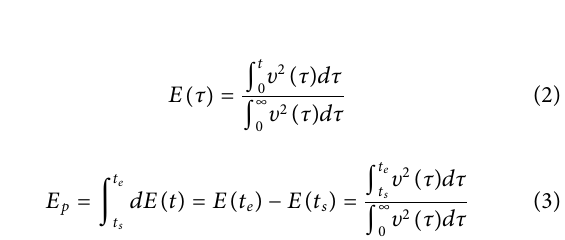
FIGURE 2 | Seismic stations and sur fi cial fault projections of the Northridge Earthquake and the Imperial Valley Earthquake.